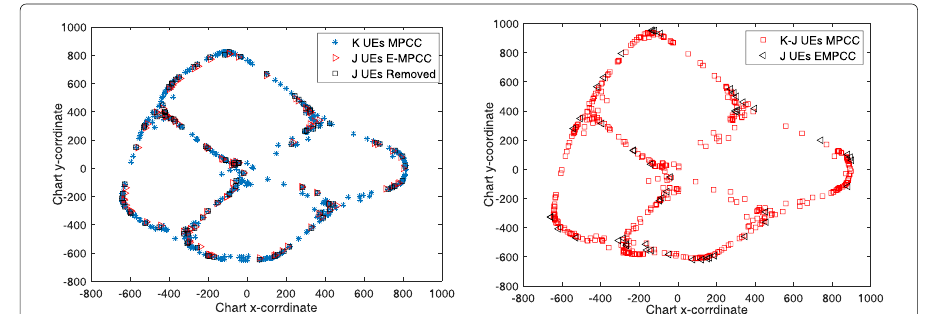
Fig. 7 Two-dimensional channel chart for 4 BSs. The channel chart location of out-of-sample UEs is in black color. Left: re-inserting removed sample. Right: inserting new sample